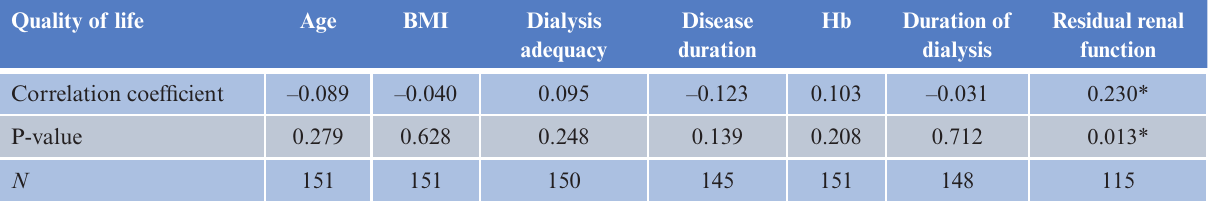
Table 3 : Correlation between the QoL scores and contributing variables (Pearson and Spearman